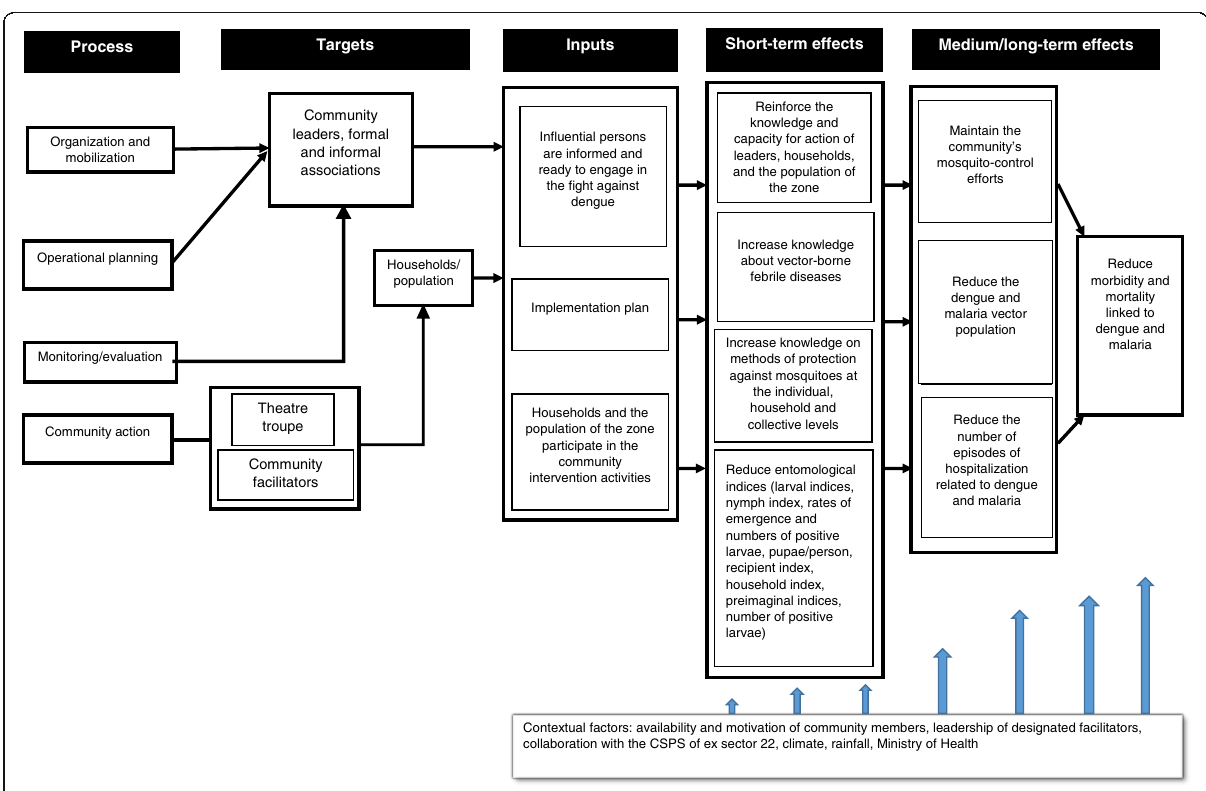
Fig. 1 Theoretical model for the community intervention against dengue in